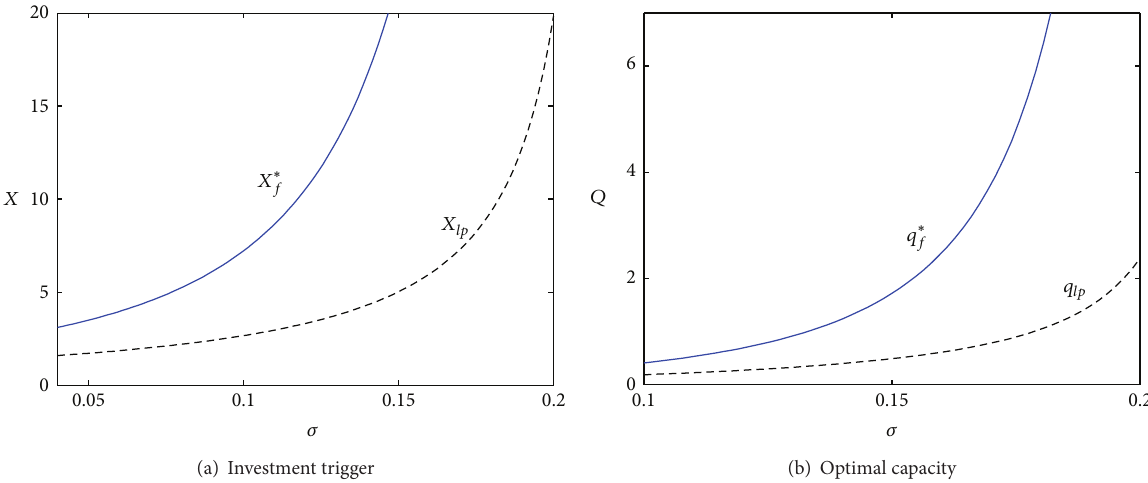
Figure 1: Investment strategies in the preemptive case. The parameter values are 𝑟 = 0.05 , 𝑘 = 40 , 𝜇 = 0.001 , and 𝛾 = 4